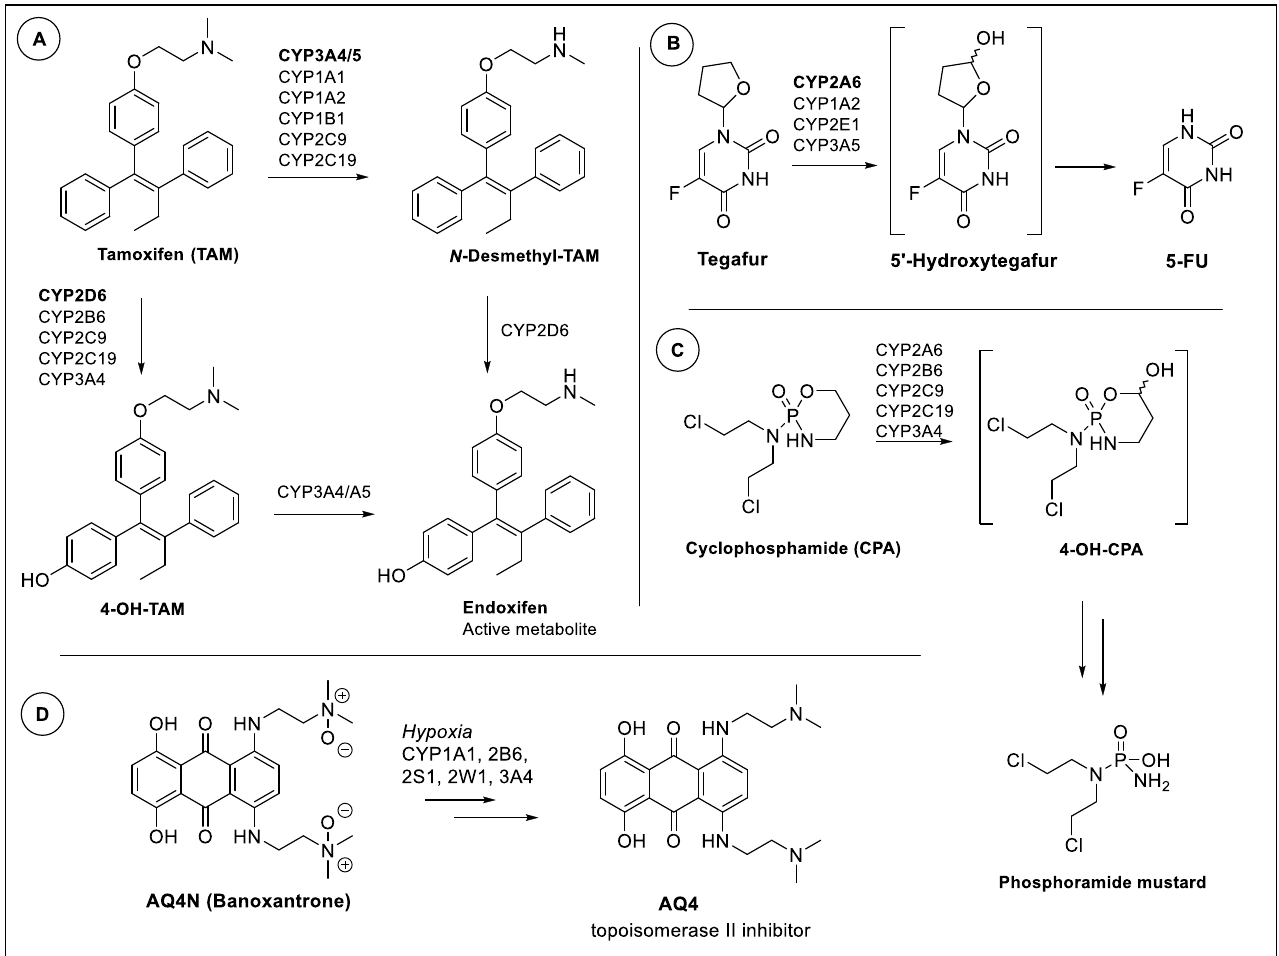
Figure 2. Non-selective bioactivation of prodrugs tamoxifen ( A ), tegafur ( B ), CPA ( C ) and tumour-selective hypoxia-activated prodrug AQ4N ( D ).